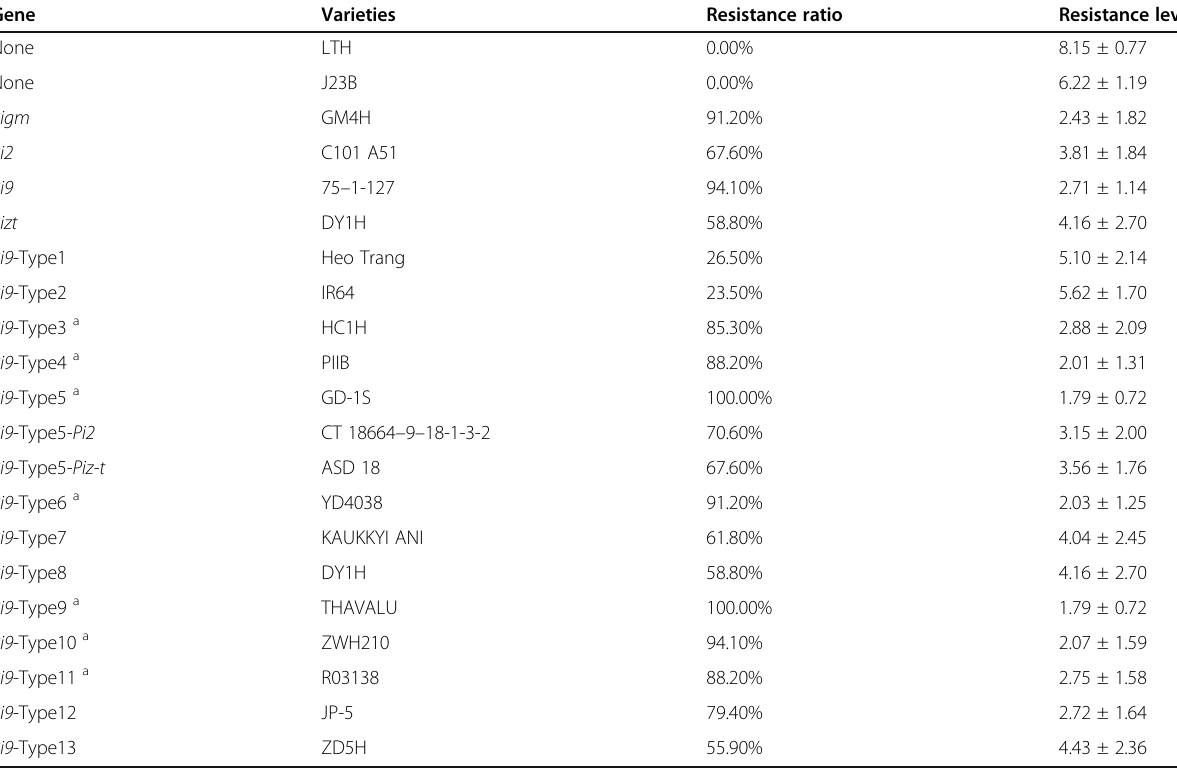
Table 4 Disease responses of Pigm , Pi2 , Pizt , Pi9 and Pi9 alleles honor plants to M. oryzae isolates